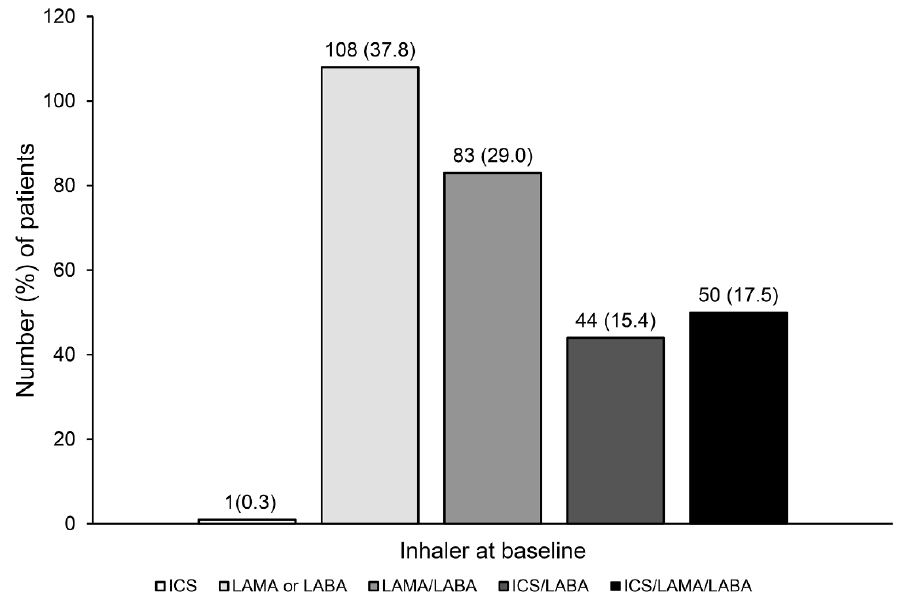
Figure 2. Prescription status of inhaler treatment in GOLD A COPD subjects. CAT: chronic obstructive pulmonary disease assessment test; COPD, chronic obstructive pulmonary disease; GOLD, Global Initiative for Chronic Obstructive Lung Disease; ICS, inhaled corticosteroid; LABA, long-acting beta2-agonist; LAMA, long-acting muscarinic antagonist.